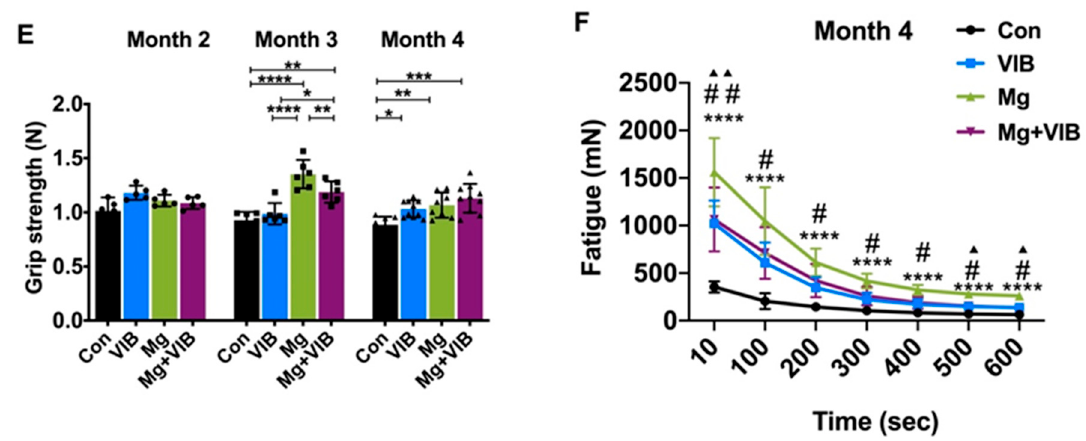
Figure 3. Muscle strength and function of SAMP8 mice upon different time points in treatment groups (n = 5). ( A ) twitch force, ( B ) specific twitch force, ( C ) tetanic force and ( D ) specific twitch force of VIB group were significantly higher than in all other three groups at month 3 post treatment, while the Mg group presented dominantly higher muscle twitch and tetanic contraction parameters at month 4. No significant difference was found at month 2. ( E ) Grip strength of the Mg group was significantly higher than that of the other groups at month 3, and the Mg + VIB group presented significantly higher grip strength at month 4. * p < 0.05, ** p < 0.01, *** p < 0.001 and **** p < 0.0001. ( F ) Mg treatment and combination treatment showed a higher fatigue curve and significantly higher fatigue force value than the Con group at every time point at month 4. The Mg group compared with Con group: **** p < 0.0001. The VIB group compared with the Con group: ▴ p < 0.05, ▴▴ p < 0.01 and the Mg + VIB group compared with the Con group: # p < 0.05, ## p < 0.01.